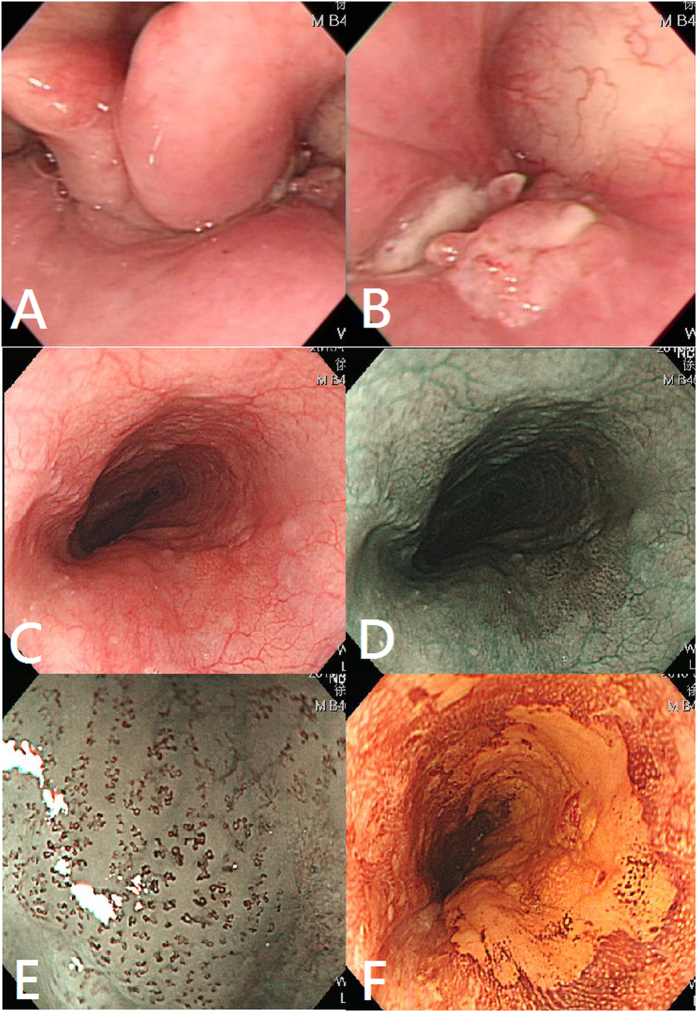
(A,B) A right-sided hypopharyngeal cancer. (C) An uneven hyperemic mucosa surface under white-light endoscopy. (D,E) Brownish discoloration of mucosa with abnormal microvasculatures under narrow-band imaging with magnifying endoscopy. (F) A well-demarcated Lugol-unstained area. Pathology from endoscopic submucosal dissection reporting squamous cell carcinoma invading the lamina propria.